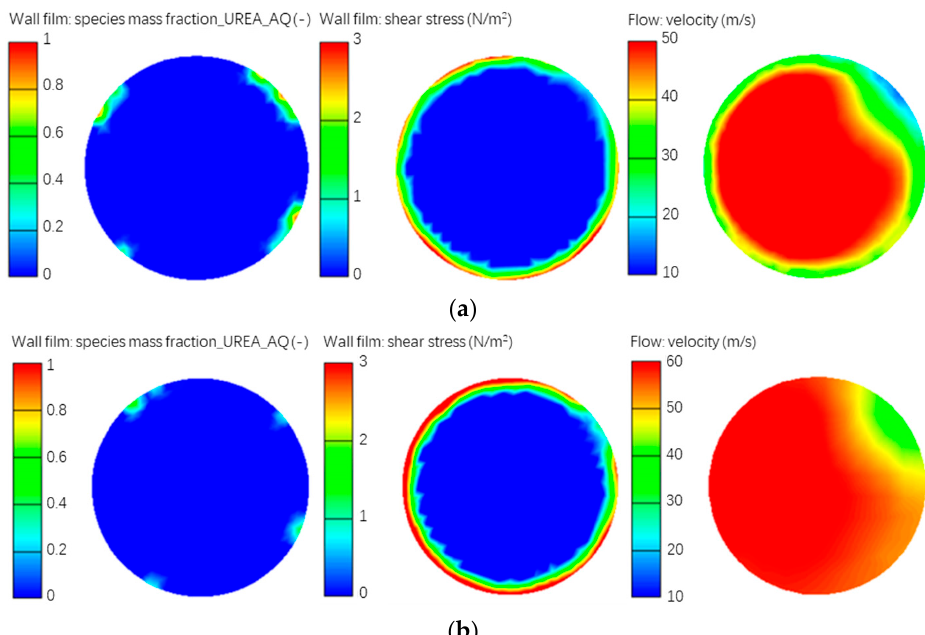
Figure 21. Comparison results of flow field simulation before and after optimization. ( a ) Before optimization; ( b ) After optimization.